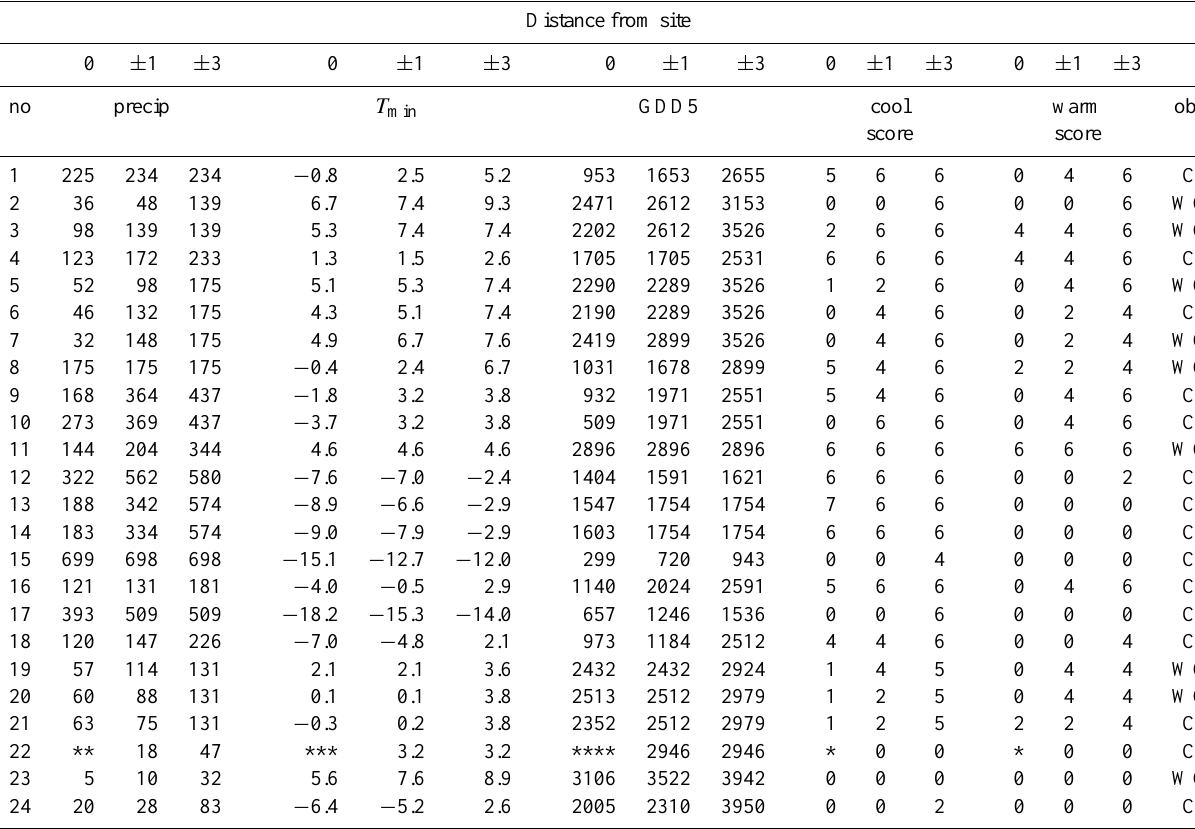
Table 5. Summary of the ECHAM5 T106 run (T106EH5) using JJA precipitation, minimum temperature and growing degree days above 5 ◦ C (GDD5) for continental sites. Values at the nearest grid point of the sites as well as maximum values within a distance ± 1 or 3 grid points are given for each variable. Unknown values are marked by * because the climatology assumed this point to be water. The category of trees found during the LGM is given by W for warm-loving trees and C for cold-tolerant